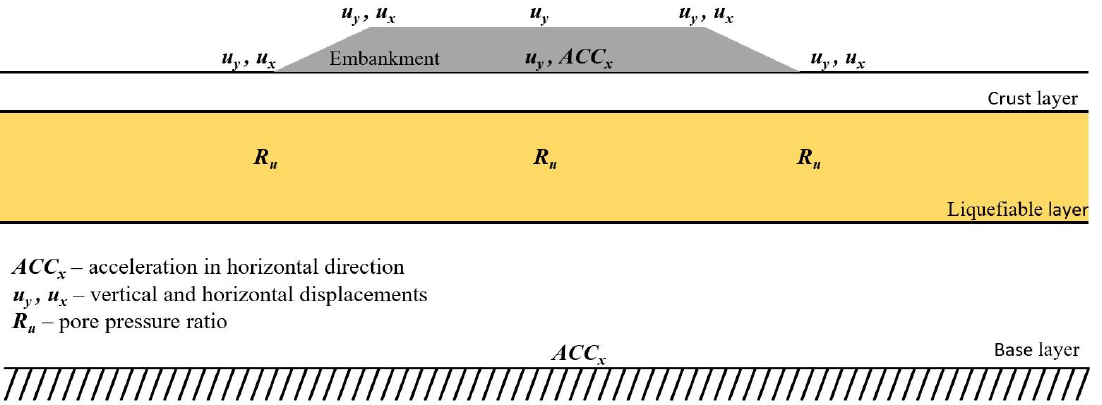
Figure 4. Locations of the selected recording points.